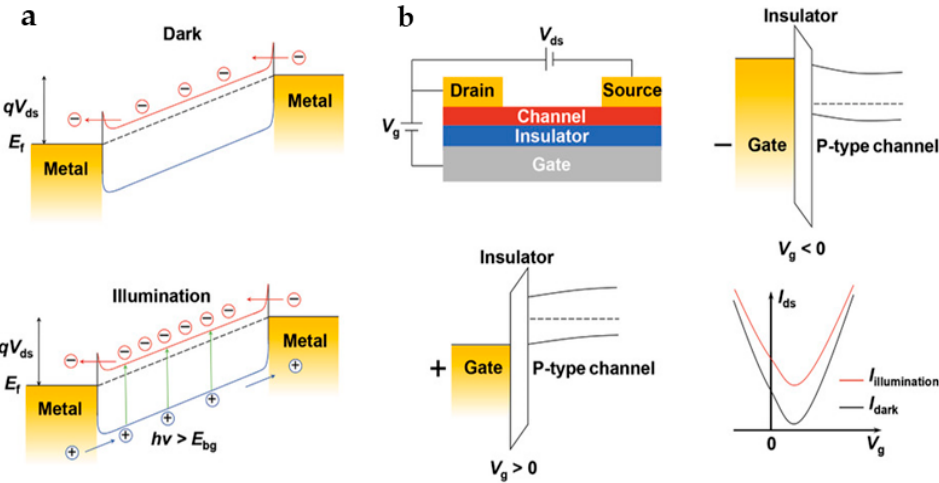
Figure 3. ( a ) A schematic diagram of the PC effect mechanism. Under dark conditions (upper panel), a semiconductor channel contacted by two metal electrodes produces a dark current I dark at a bias voltage of V ds . Under illumination (bottom panel), the extra carriers excited by incident photons lead to a large photocurrent I light at a bias voltage of V ds . ( b ) The principle diagram of a back-gated PD (top-left panel), the band diagram of the gate/insulator/channel of the PD under the dark conditions at a negative gate bias (top-right panel) and at a positive gate bias (bottom-left panel), and the relationship between the source-drain current and gate bias under illumination and dark conditions (bottom-right panel). (Reprinted with permission from ref. [30]. Copyright 2021 John Wiley and Sons